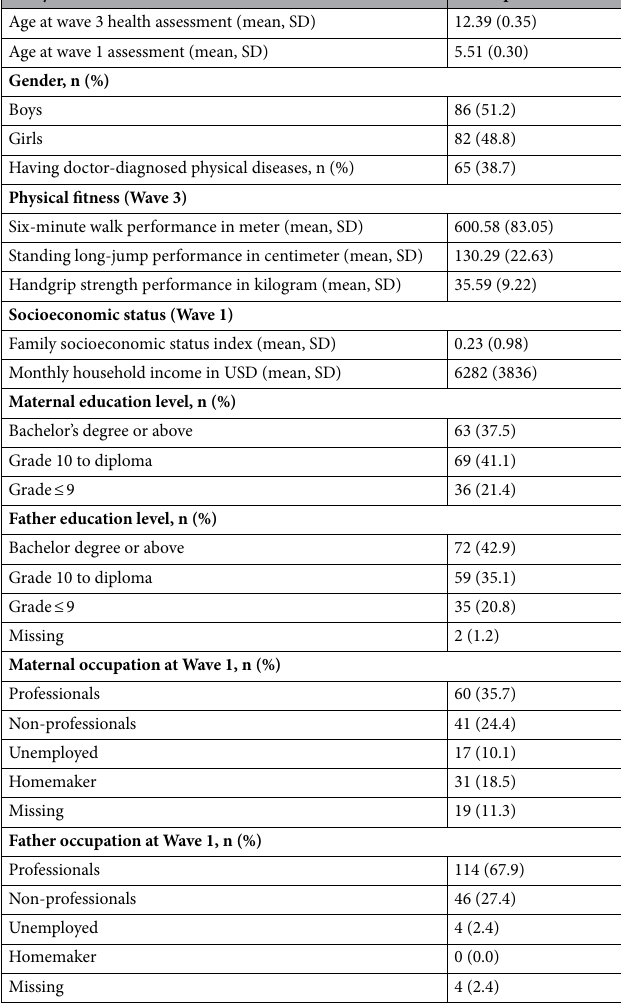
Table 1. Subject characteristics (n = 168).